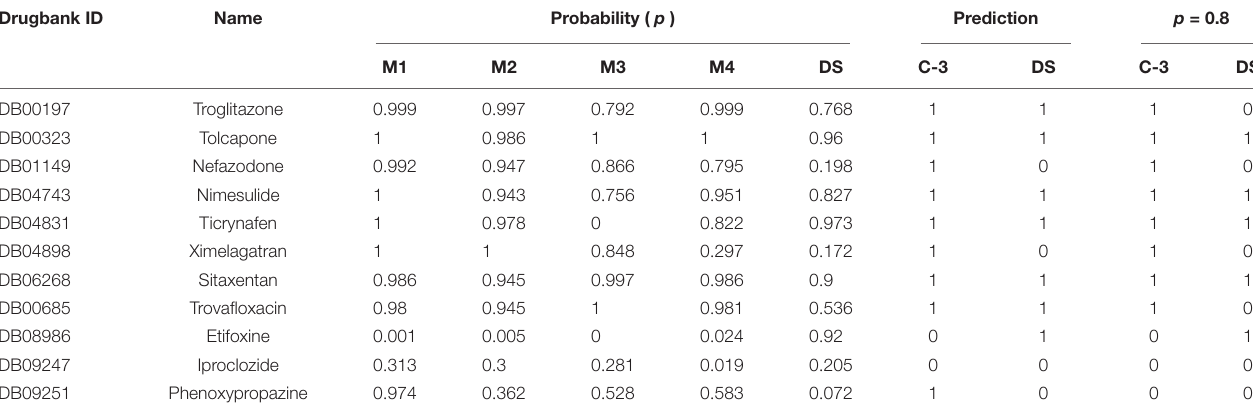
TABLE 2 | Comparison of the hepatotoxic prediction results between consensus model 3 (C-3) and Discovery Studio (DS) for 11 withdrawn drugs due to hepatotoxicity.